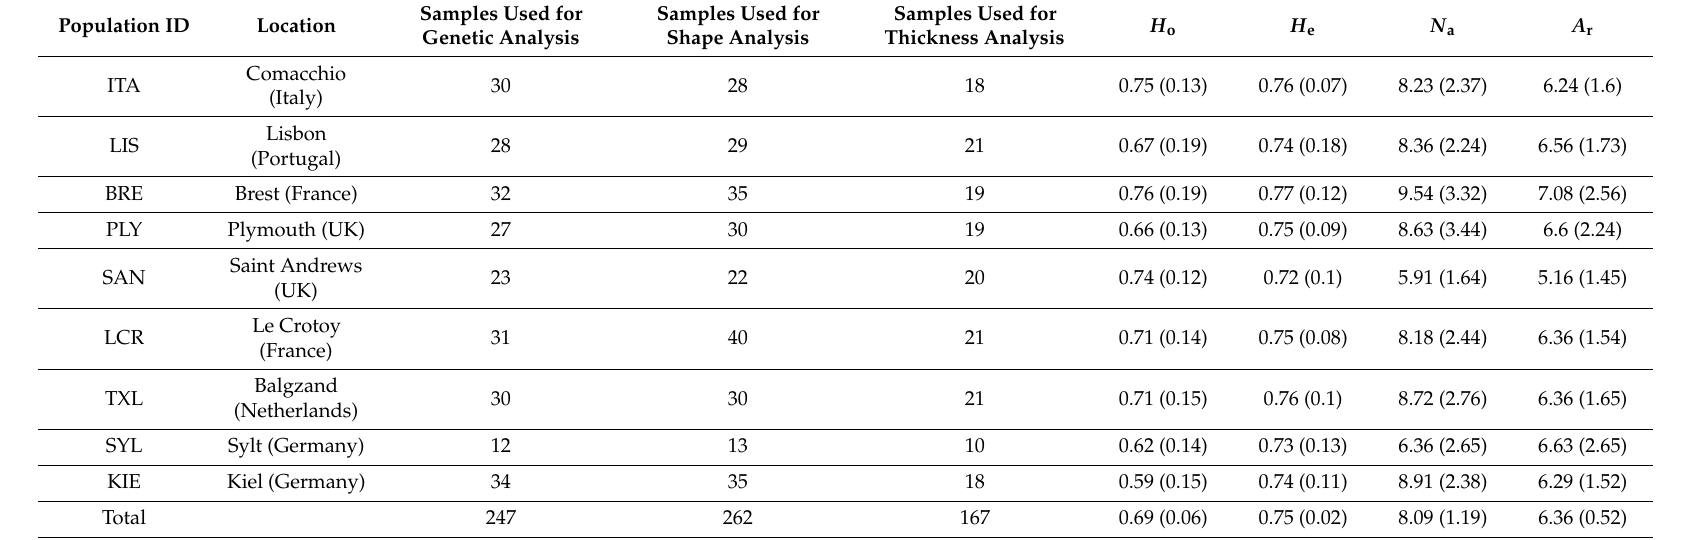
Table 1. Table of sampling locations, including the number of samples used for the genetic and morphometric analyses. Four genetic diversity statistics are also shown. Observed heterozygosity (H o ), expected heterozygosity (H e ), the number of alleles (N a ) and allelic richness (A r ) are given as values averaged across loci, with standard deviations reported in